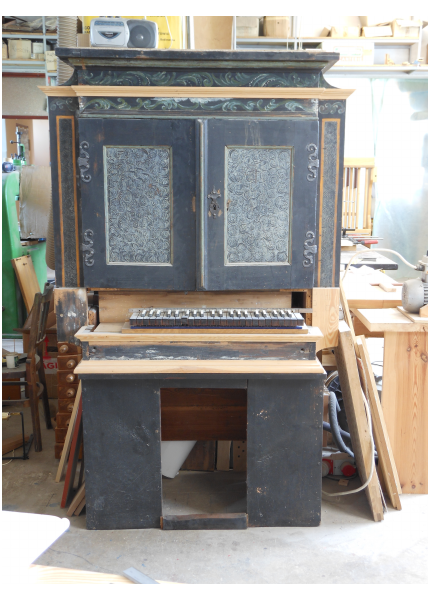
Figure 2. Closed chest organ (with reconstructed